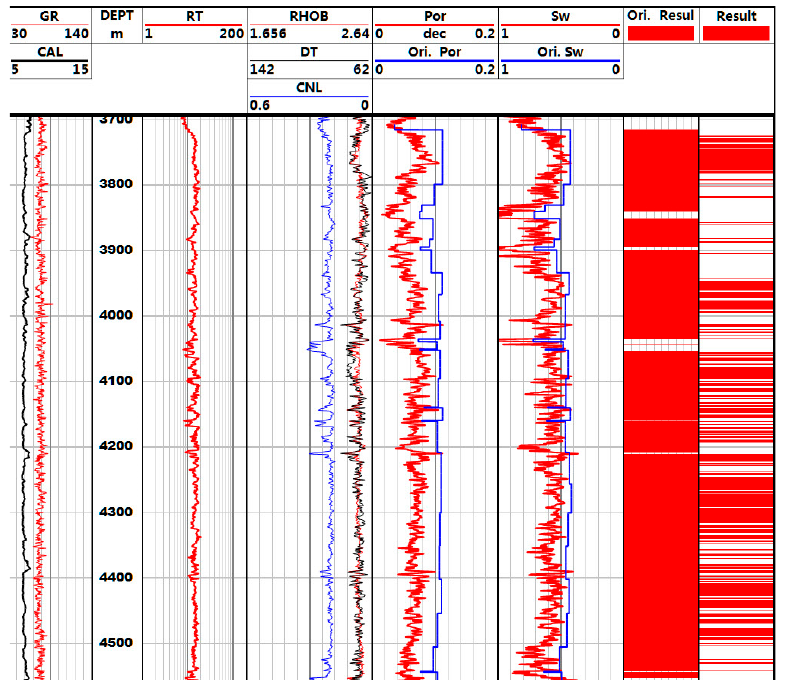
Figure 15. The logging interpretation result for Well XX21001.